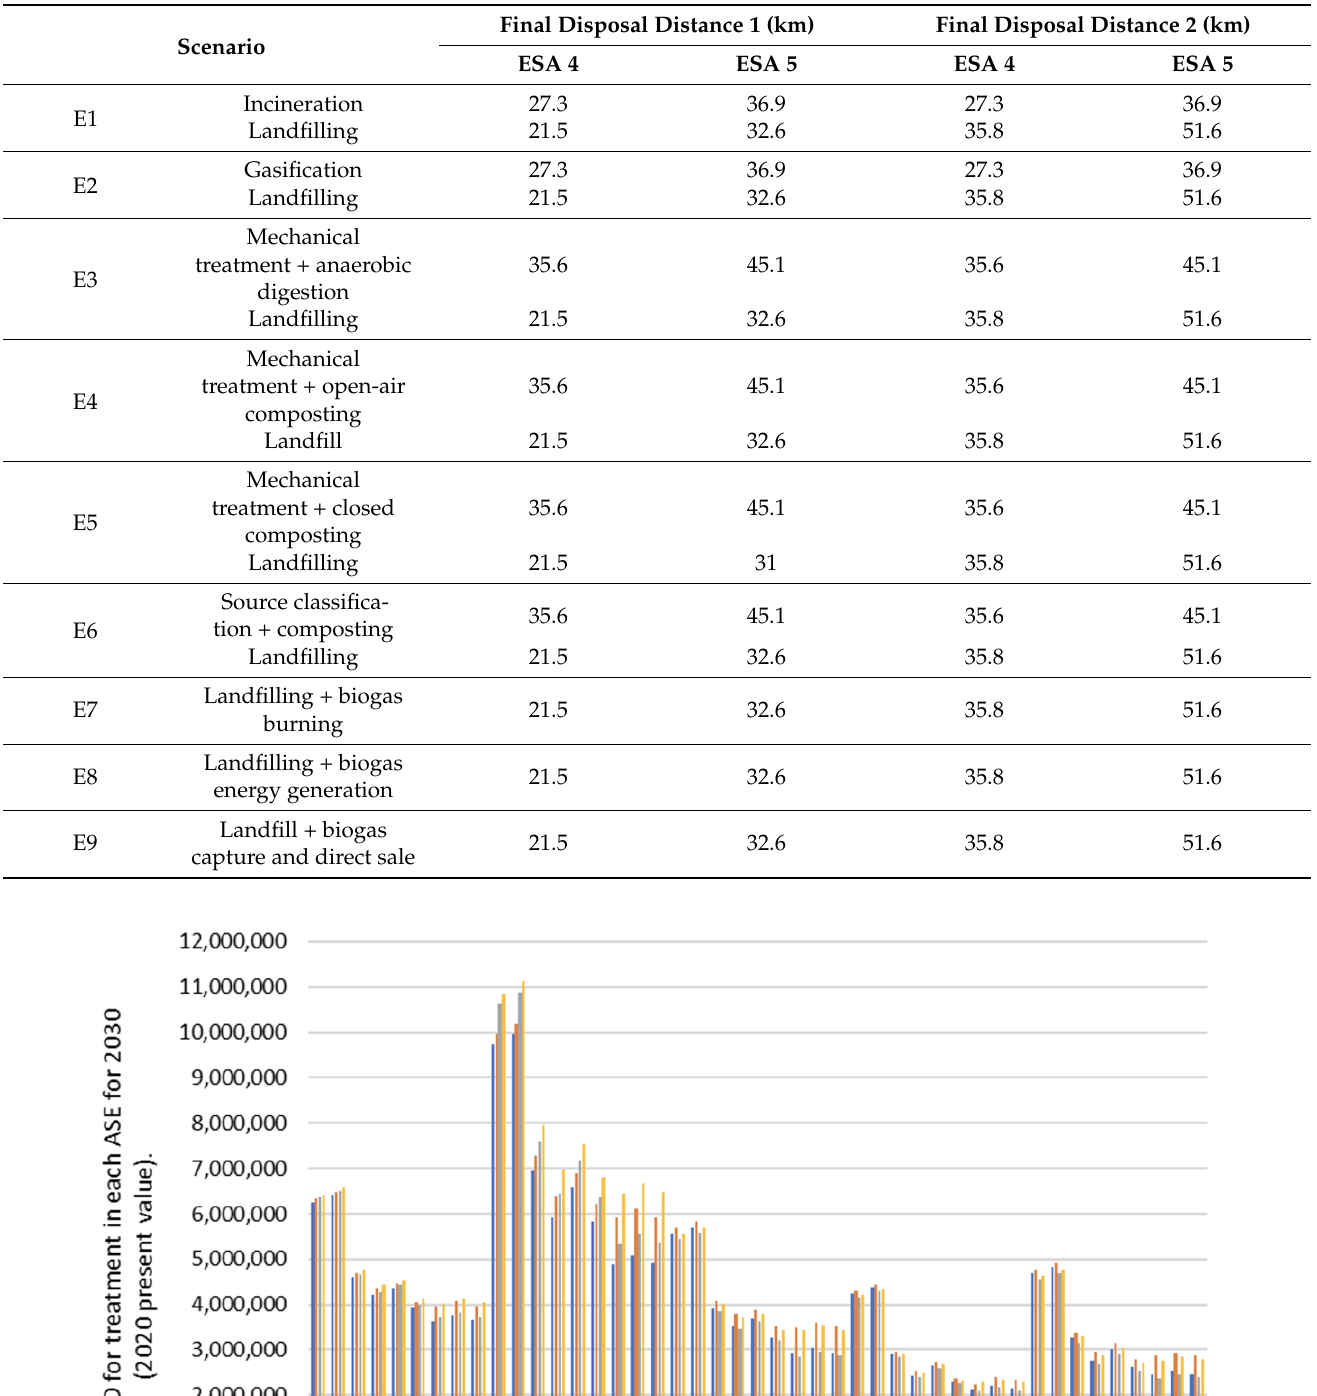
Figure 10. Location map of work distance 1 (Doña Juana landfill) and work distance 2 (Nuevo Mon- doñedo landfill location zone) [71]. Table 4. Working distances considered in the modeling.